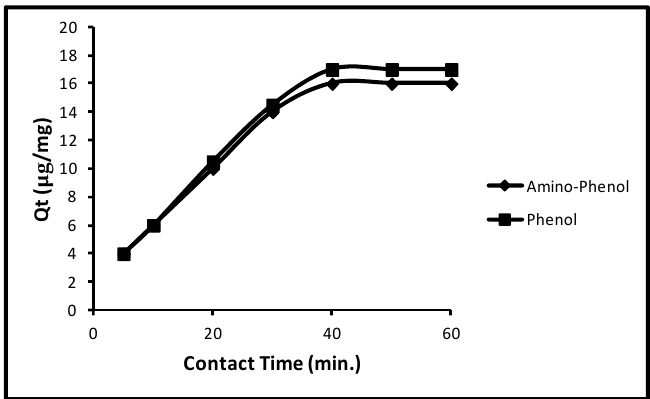
Figure 3. E ff ect of extraction time of Figure 3. Effect of extraction time of phenols.